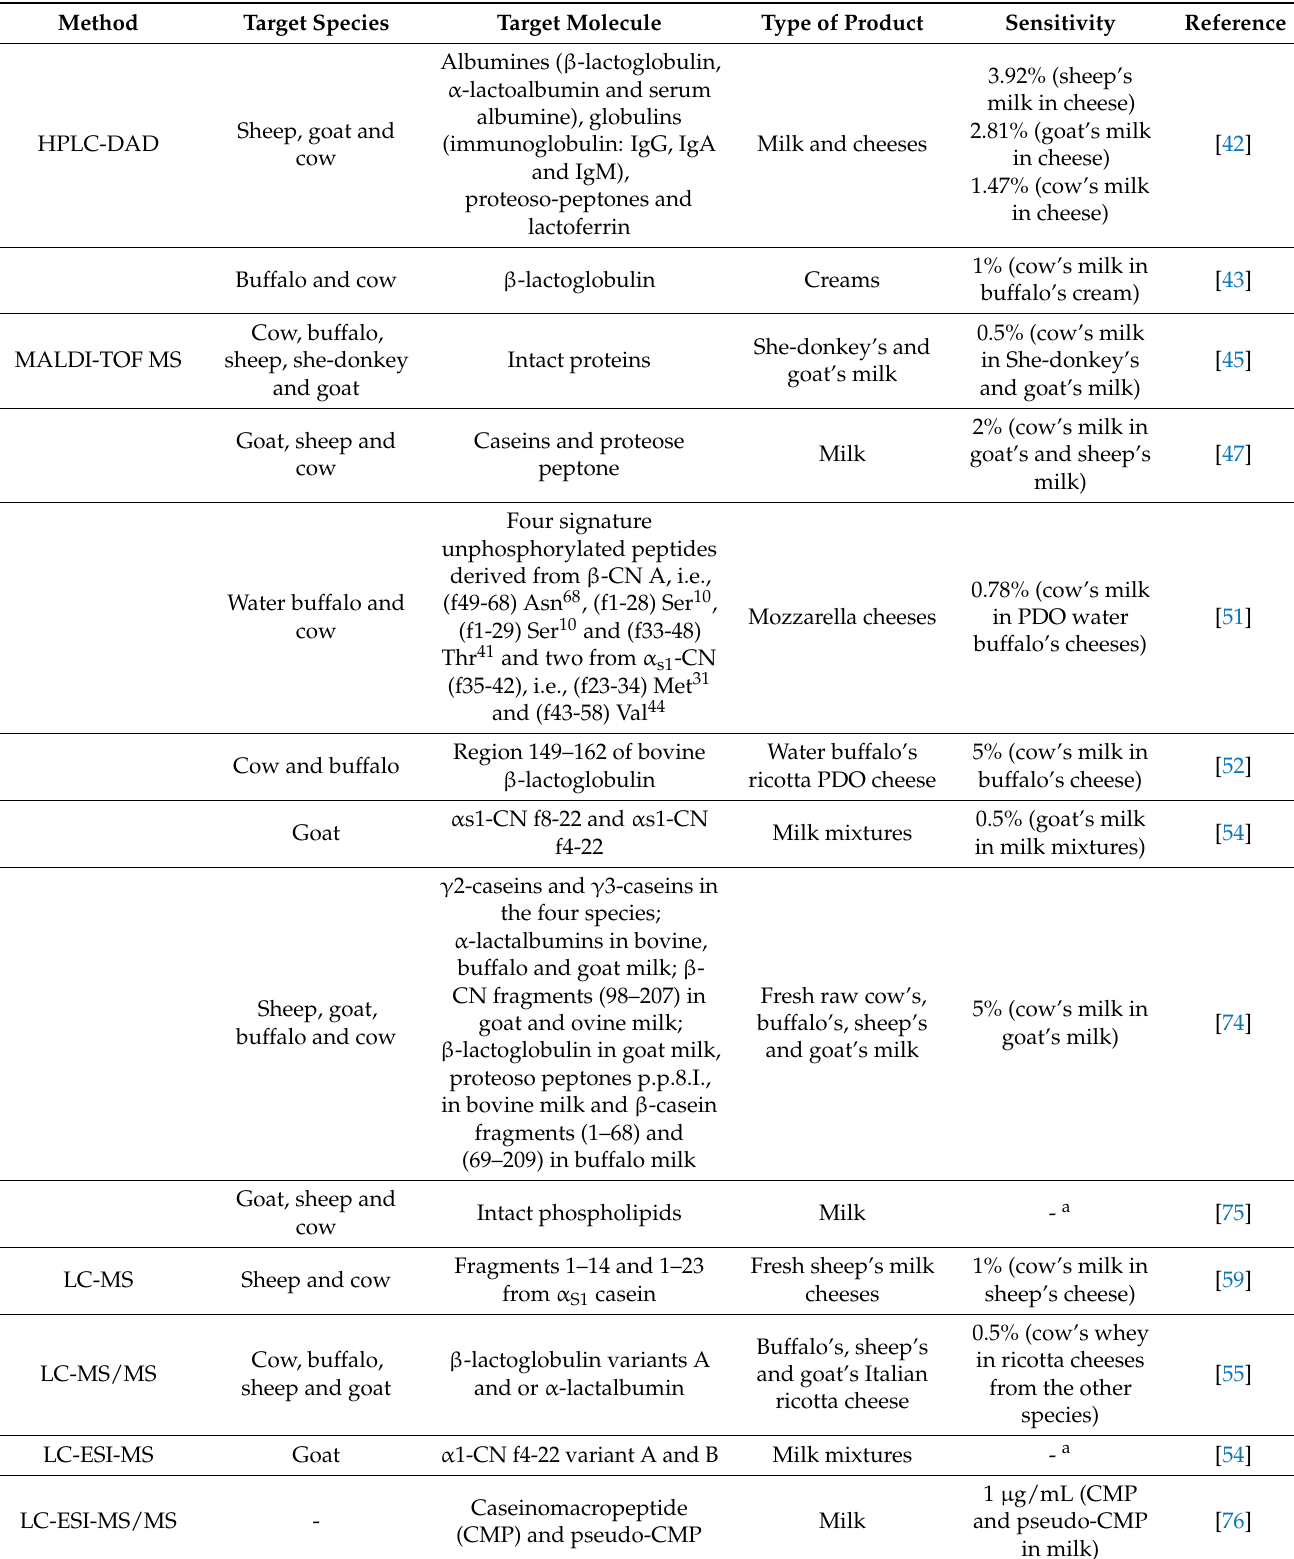
Table 2. Summarized information of reported chromatographic and mass spectrometry techniques applied to species identification in dairy